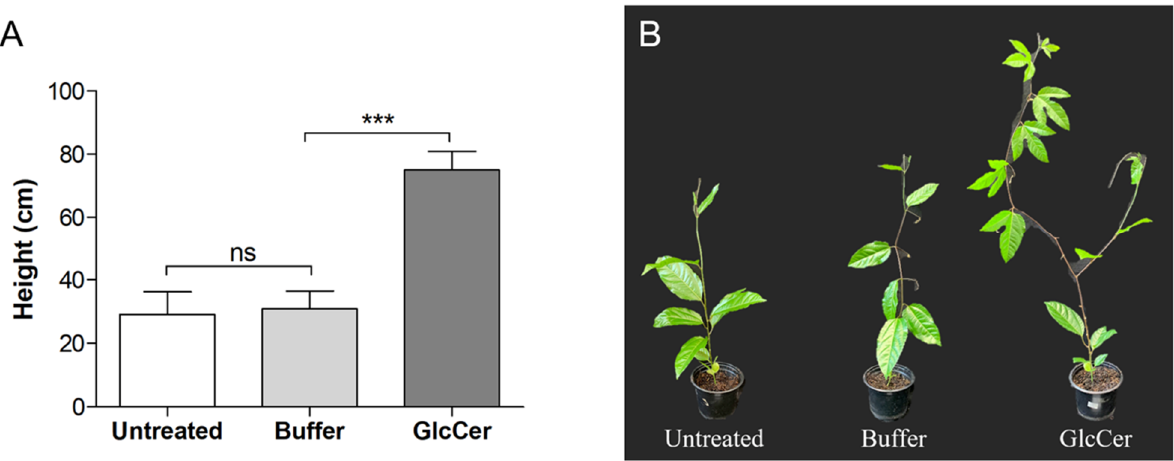
Figure 8. Effects of GlcCer species on plant height. ( A ) plant height measured after 40 days after being sprayed. ( B ) Appearance of plants after 40 days after being sprayed. GlcCer (100 µg/mL) was used to spray plants and controls were sprayed with only buffer. Untreated plants were used as negative control. Untreated: plants without treatment; Buffer: plants sprayed with potassium phosphate buffer 0.01M; and GlcCer: plants sprayed with 100 µg/mL GlcCer. The height of five plants per treatment was determined 40 days after spraying. ns = not significant. *** p < 0.001.